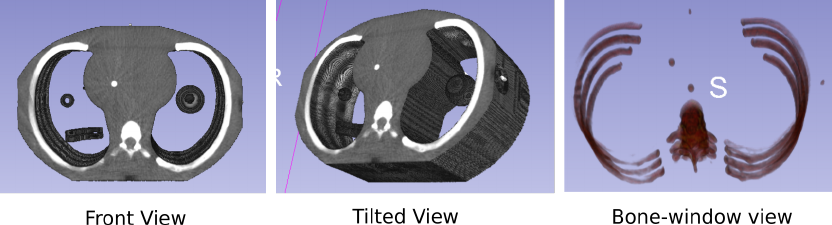
Figure 3. Anthropomorphic phantom shown with front ( left ) and tilted ( middle ) views. A bone- window view is also shown ( right ) where intensities are windowed to expose only the bones. As can be seen, the phantom replicates human-like